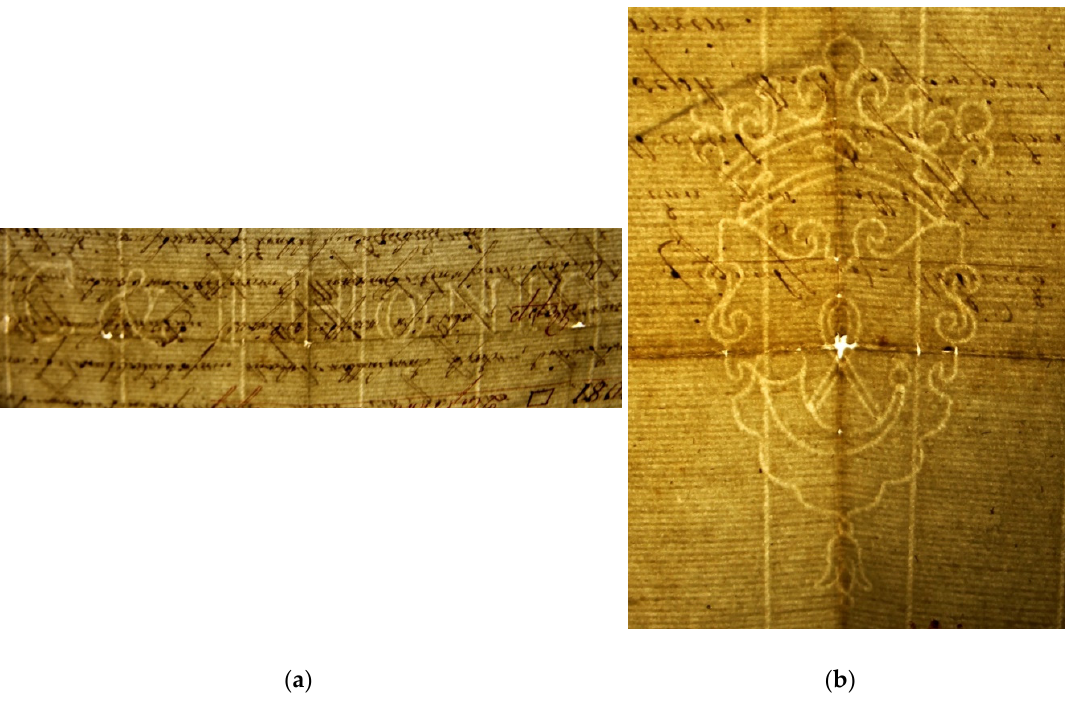
Figure 1. ( a ) Watermark on page 2; ( b ) watermark on page 4.